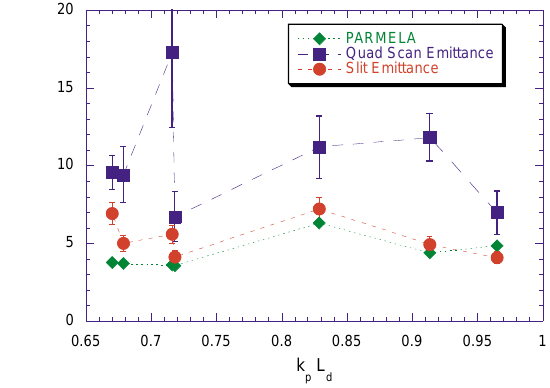
FIG. 7. (Color) PARMELA simulations of the emittance at the quadrupole and the measured emittance using both measurement